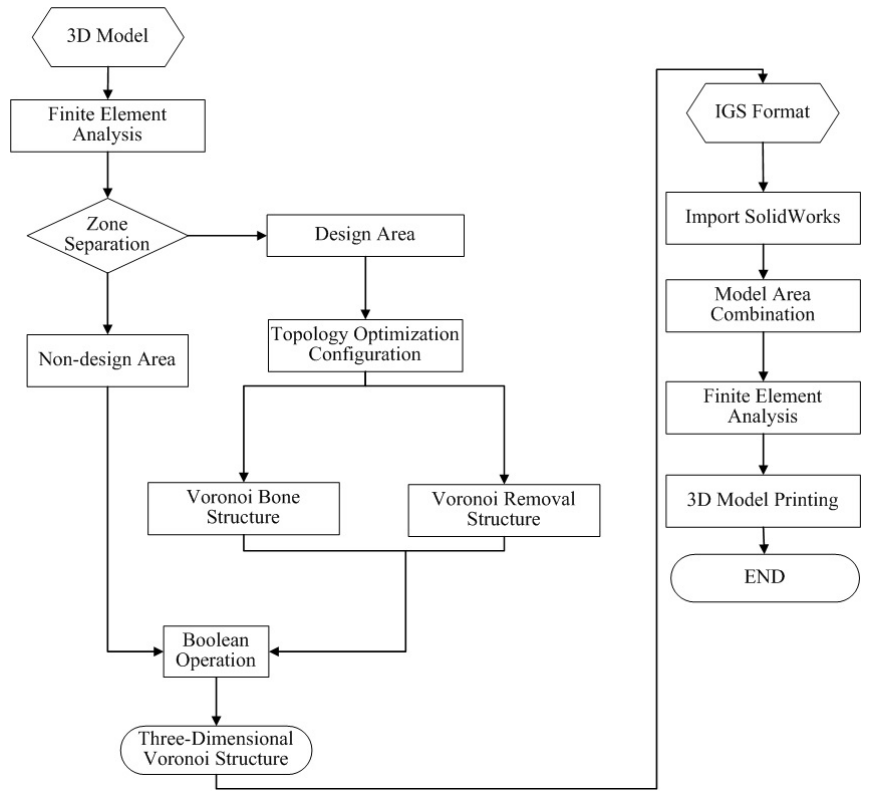
Figure 11. Flowchart of robot arm optimization.